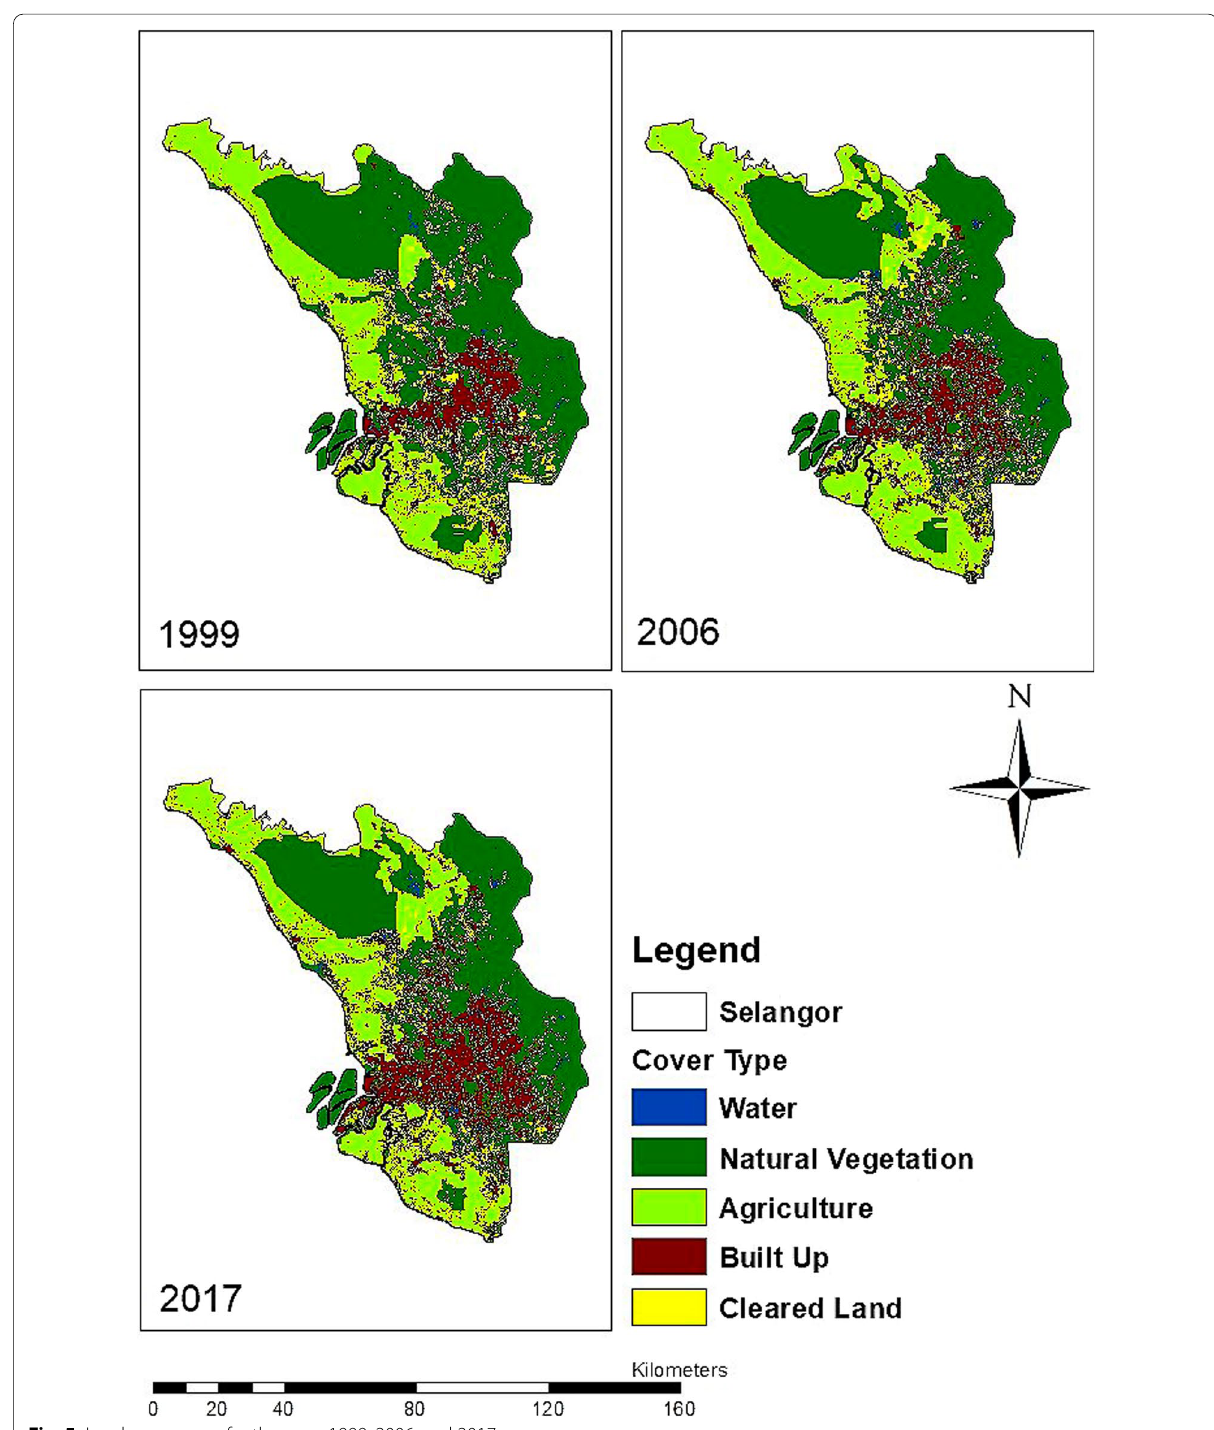
Fig. 5 Land cover maps for the years 1999, 2006, and